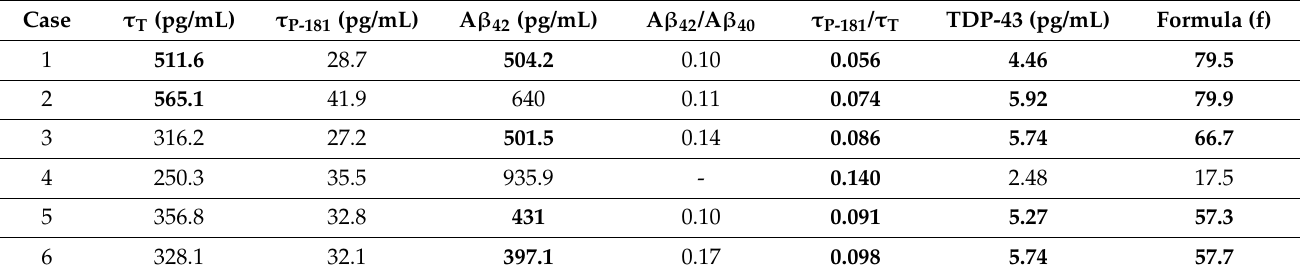
Table 2. CSF biomarker levels in the presented